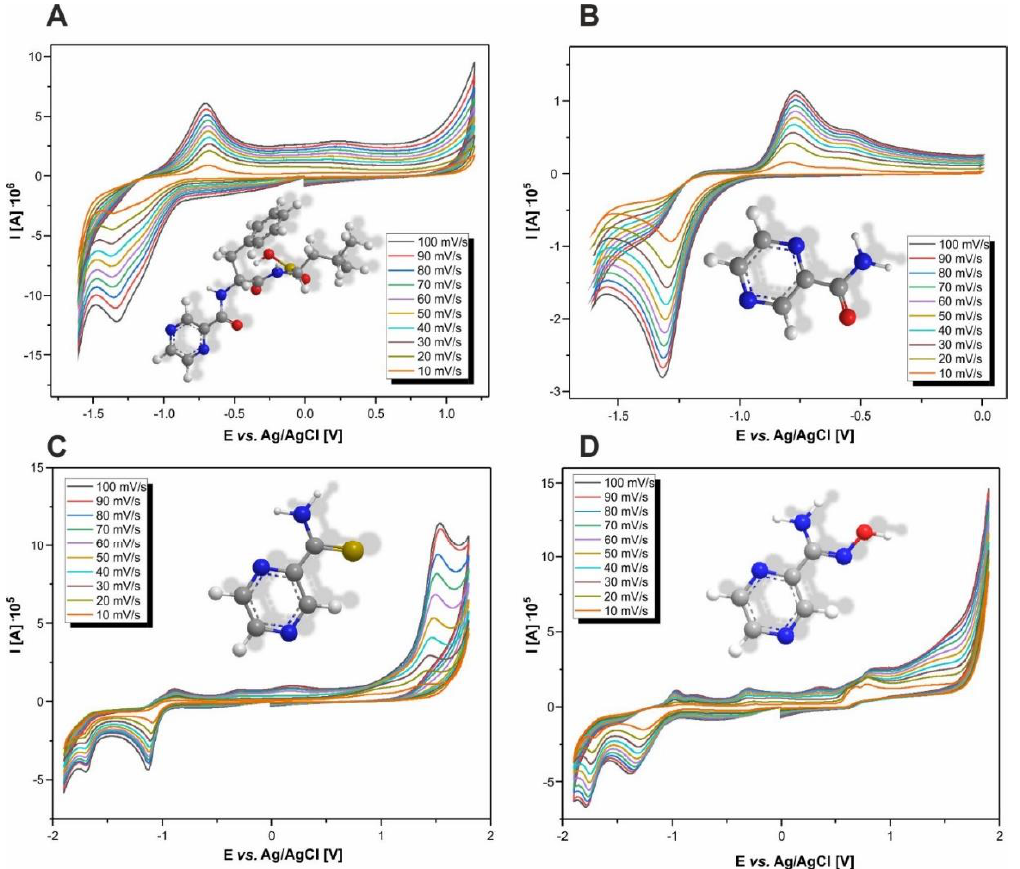
Figure 4. Voltamograms of selected pyrazine derivatives made at different scanning rates of CV signals registered by using pure GCE for: 1.25 mM BZM solution ( A ); 2.00 mM PZA ( B ), PTCA ( C ), PAOX ( D ) solutions.